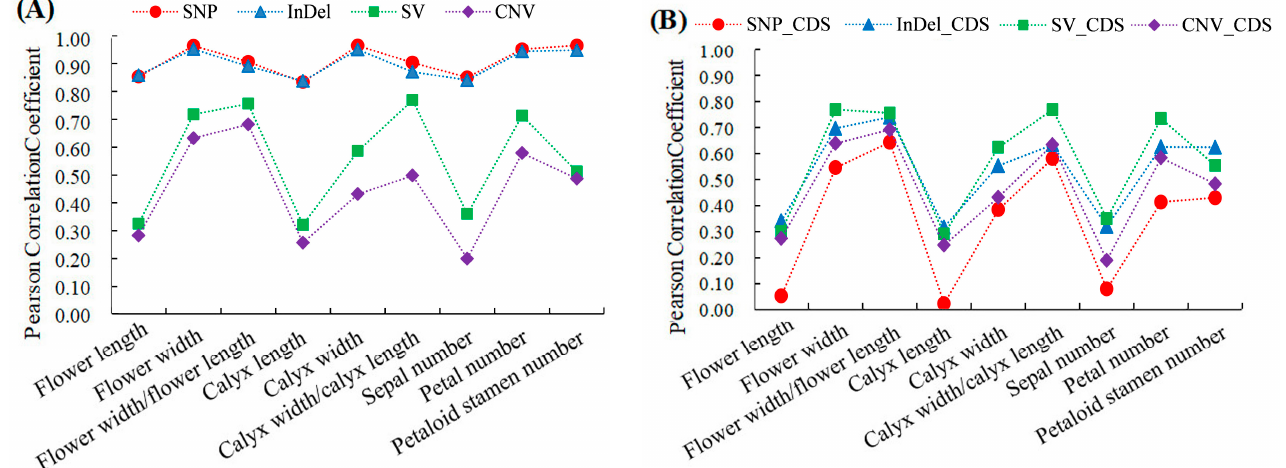
Figure 3. Correlation analysis between four variations of number and phenotypic parameters of ornamental pomegranate. ( A ) Correlation between the number of four types of variations in genome region and phenotypic parameters; ( B ) Correlation between the number of four types of variations in CDS region and phenotypic parameters.